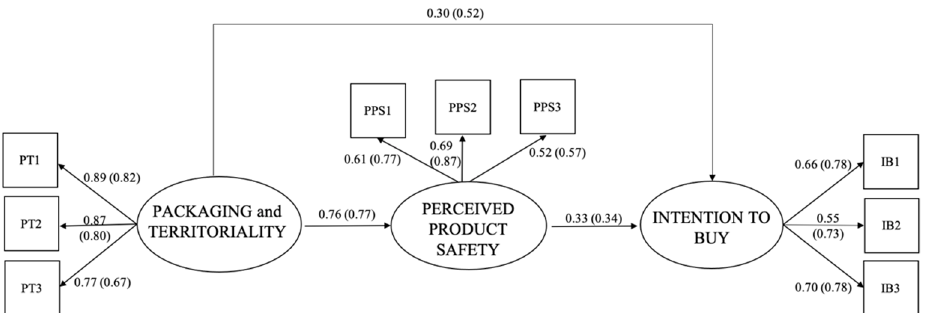
Figure 2. Results of the multi-group structural equations model. Note: Group 1 = IT—outside brackets; Group 2 = (FR)—in brackets.